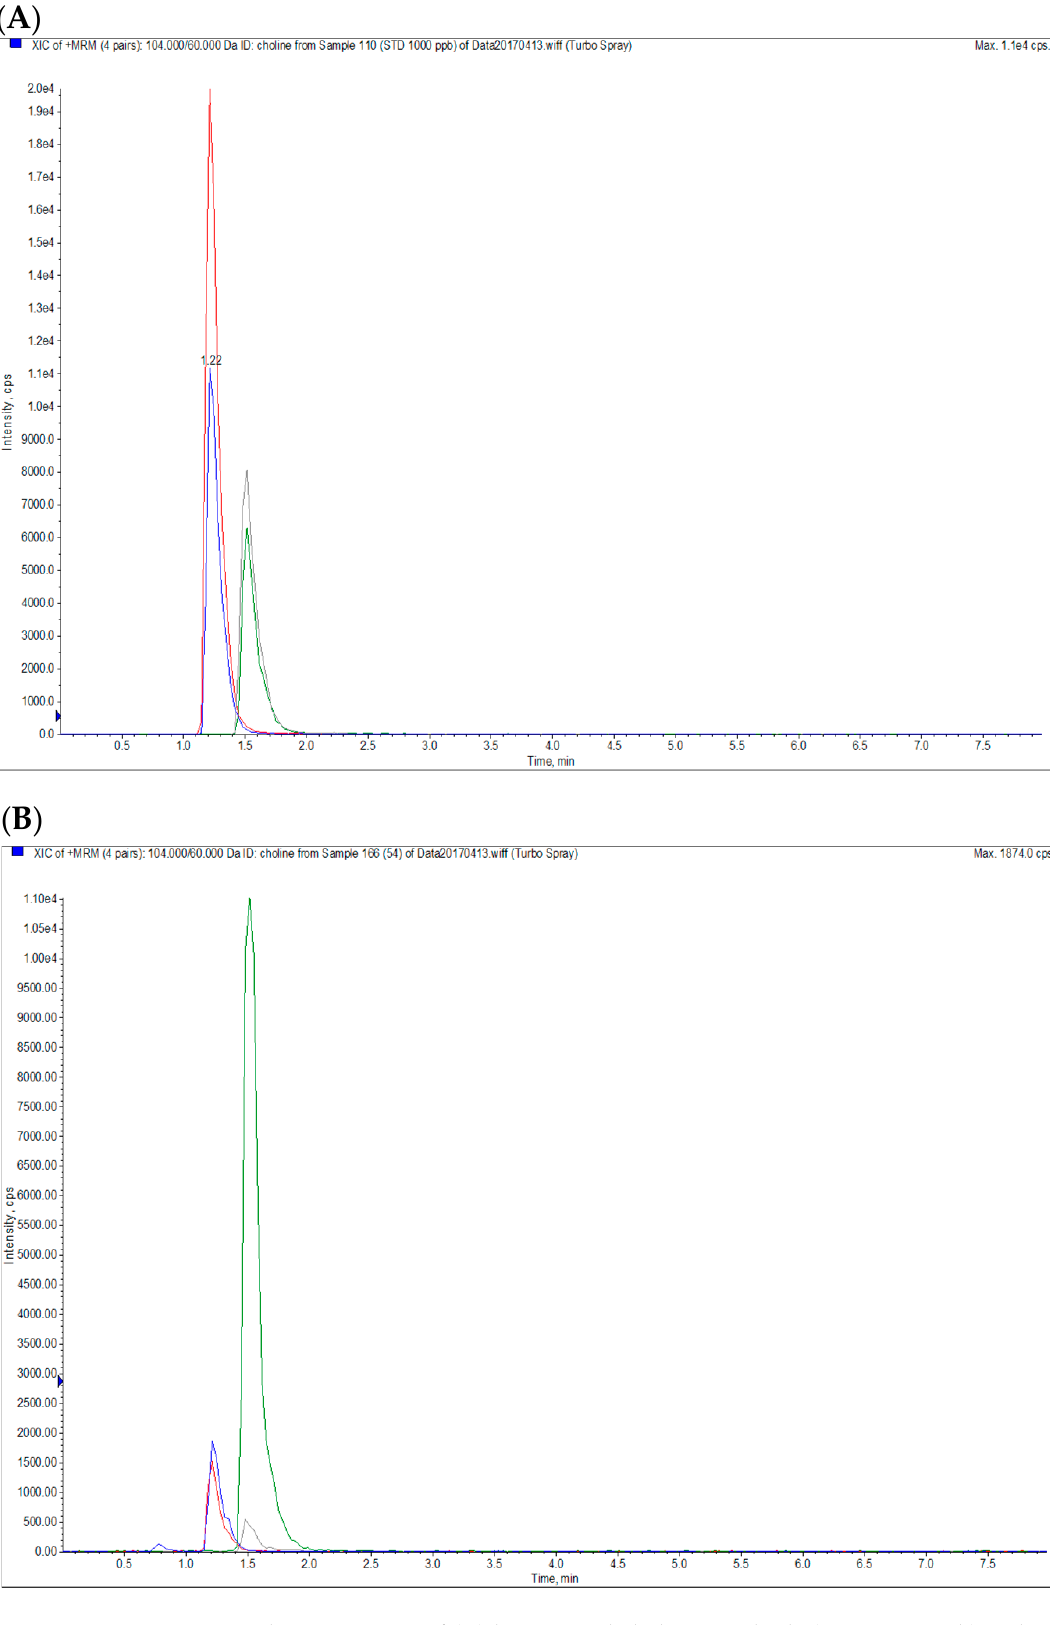
Figure 2. LC MS / MS Chromatograms of ( A ) betaine and choline standards (10 ng / mL each) and Figure 2. LC MS/MS Chromatograms of ( A ) betaine and choline standards (10 ng/mL each) and ( B ) a ( B ) a plasma sample. Blue: choline; Red: d 9 -choline; Green: betaine; Gray: d 11 plasma sample. Blue: choline; Red: d 9 -choline; Green: betaine; Gray: d 11 -betaine.